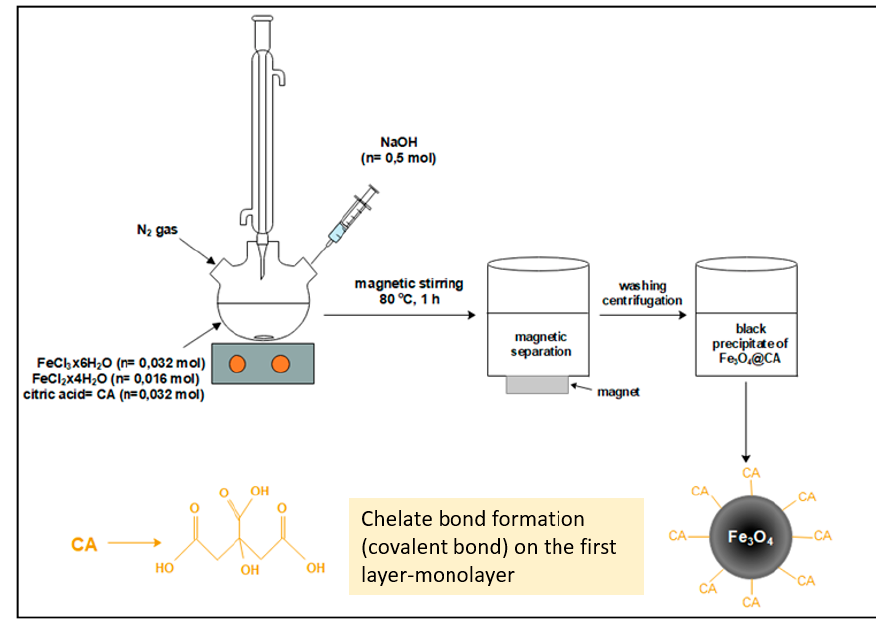
Figure 1. Schematic diagram of co-precipitation method of Fe 3 O 4 @CA